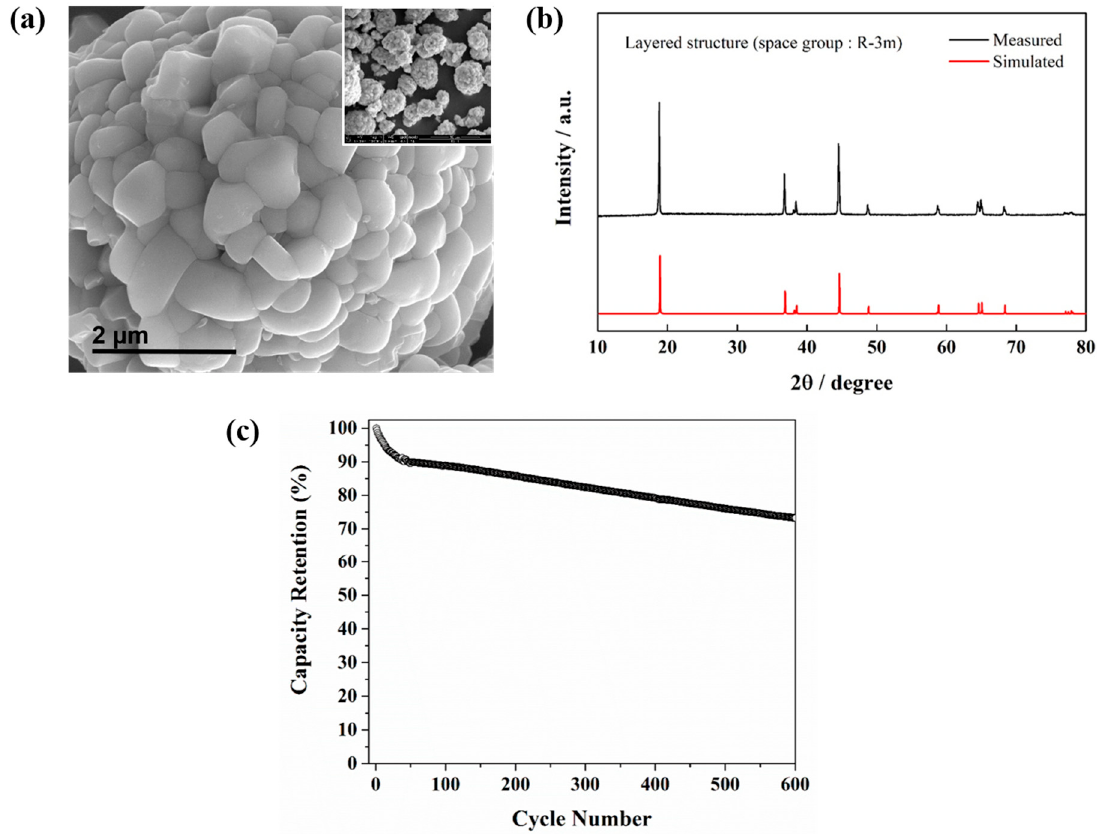
Figure 1. The morphology, structural, and electrochemical characteristics of the LiNi 0.8 Co 0.1 Mn 0.1 O 2 (NCM811) cathode material. ( a ) Focused ion beam environmental scanning electron microscopy (FIB-ESEM) image of NCM811 secondary particles in which primary particles agglomerated into spheres. ( b ) X-ray diffraction (XRD) patterns indicating that NCM811 has a layered structure in the R -3 m space group. ( c ) Electrochemical performance over 600 cycles at 45 °C tested in a pouch-type full cell.